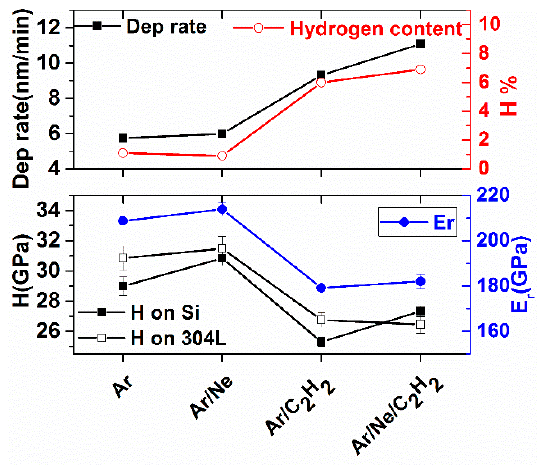
Figure 6. Deposition rate, hardness, reduced Young modulus and Hydrogen content variation as a function of deposition process.